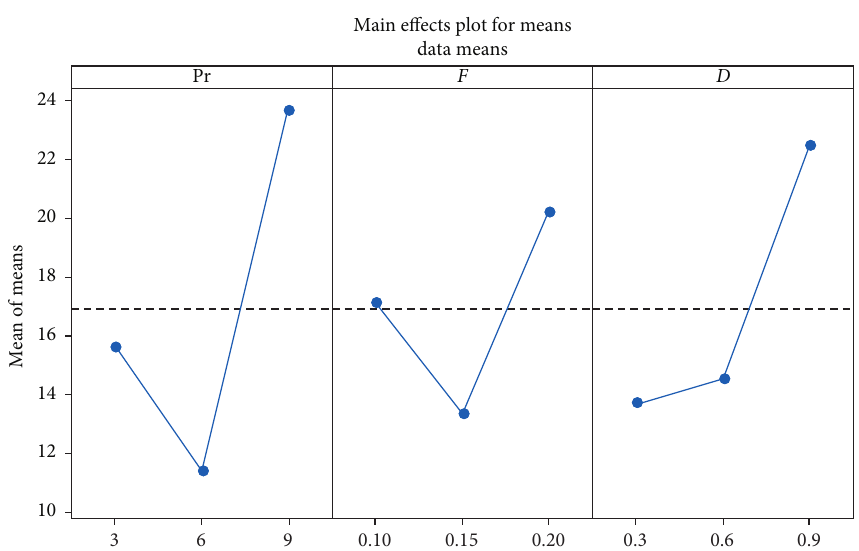
Figure 12: Tool wear, surface roughness, and thrust force focused on the important diagram based on the means; in the X -axis, Pr denotes pressure of cutting fluid (bar), F denotes feed (mm/rev), and D denotes depth of cut